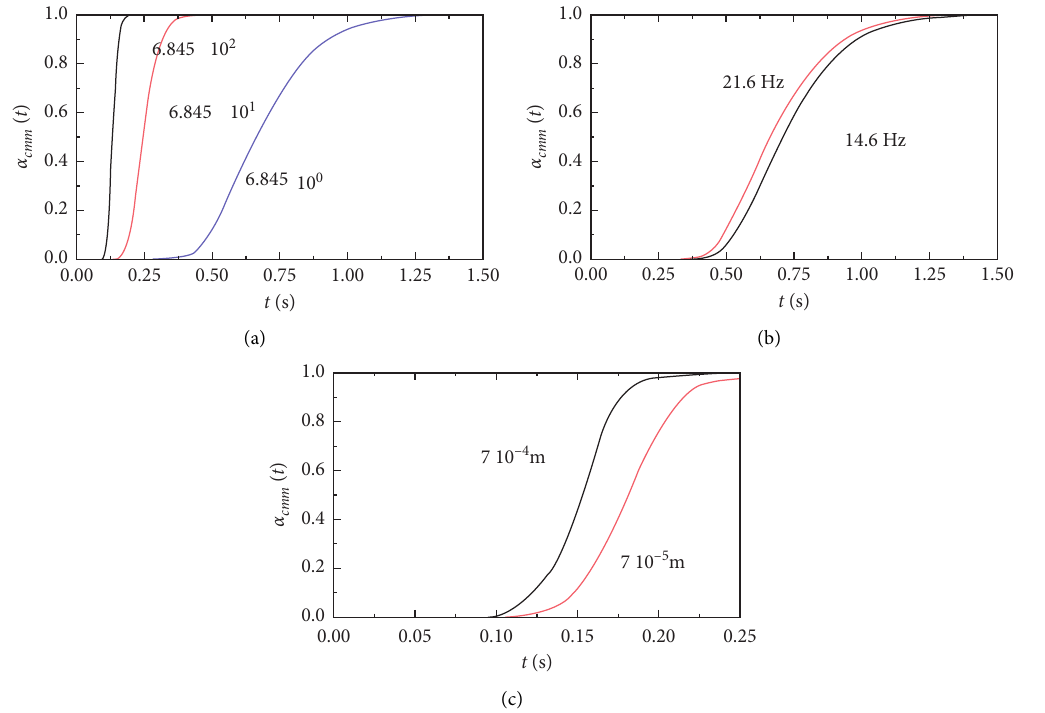
Figure 6: The cumulative degree of chemical conversion, α values of (a) rate constant of the Johnson-Mehl-Avrami kinetics, (b) frequency of the reactor swing, and (c) ignition distance. Parameter values are